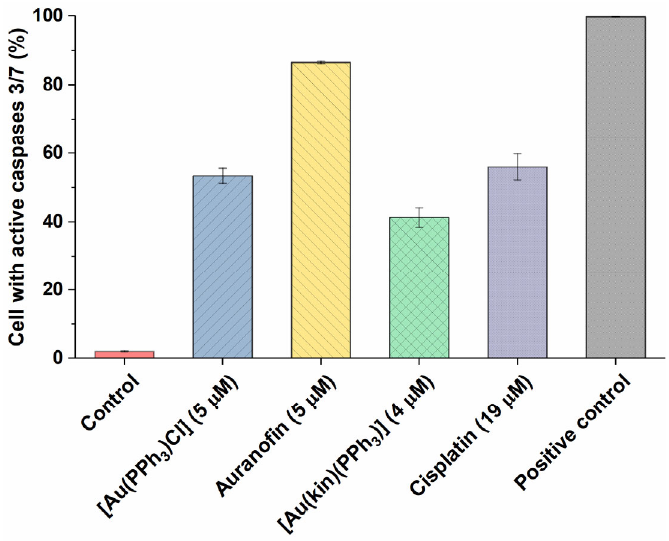
Figure 6. The ability of ( 1 ) and the reference gold(I) complexes [Au(PPh 3 )Cl], Auranofin , and a reference drug Cisplatin to activate the executioner caspases 3/7 in A2780 cells after 24 h of incubation with half ‐ cytotoxic concentrations of the compounds. The changes in all groups were found to be significant at the p < 0.0001 level with respect to the untreated control group. The positive control represents the untreated cells heated to 60 °C for 10 min.